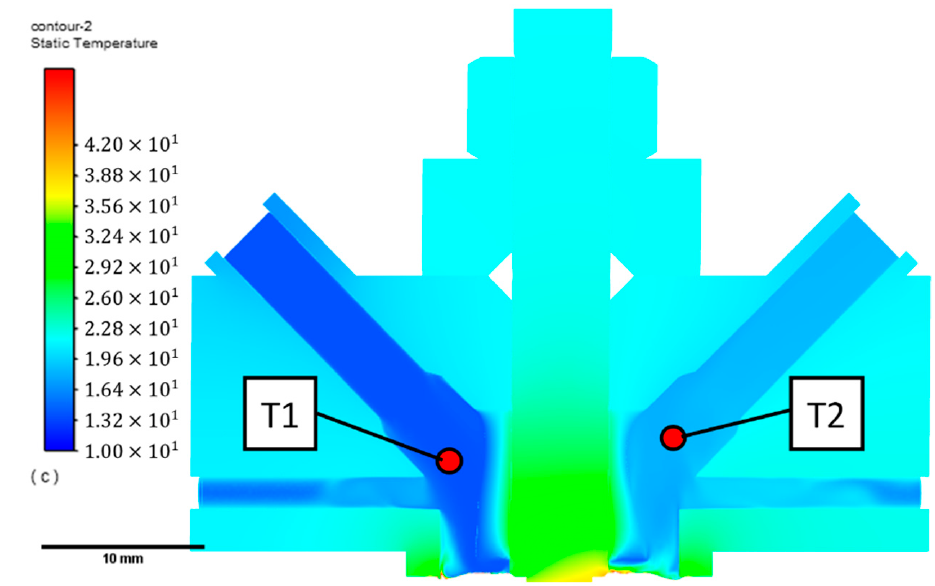
Figure 4. The best locations for measuring the fluid inlet and outlet temperatures.